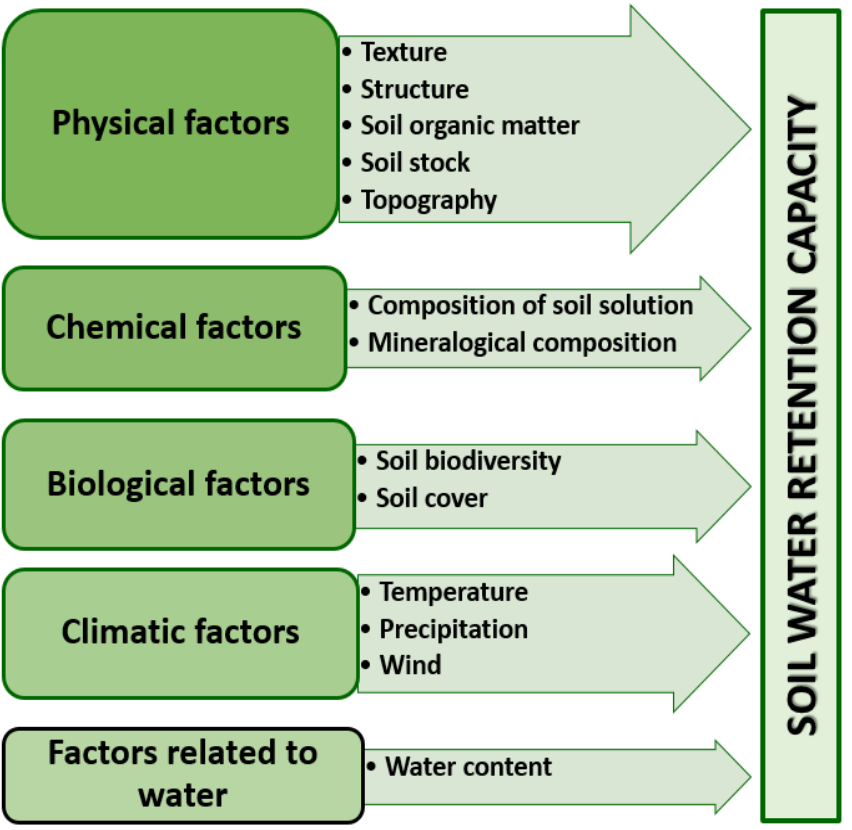
Figure 7. Factors which affect the water retention in soil.